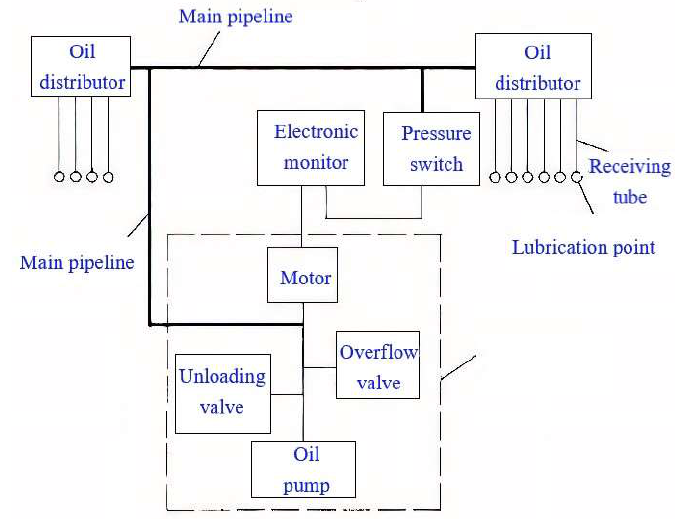
Figure 1. The structure principle of centralized lubrication system.